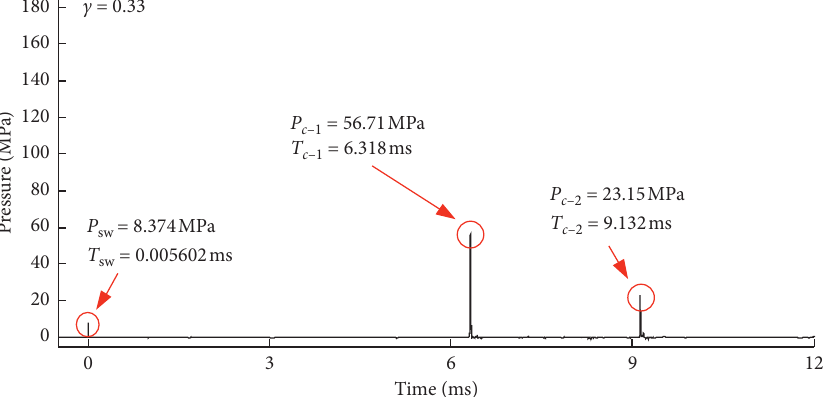
Figure 28: Pressure-time diagram of the first and second cycles of the spark-generated bubble load for c � 0.33.